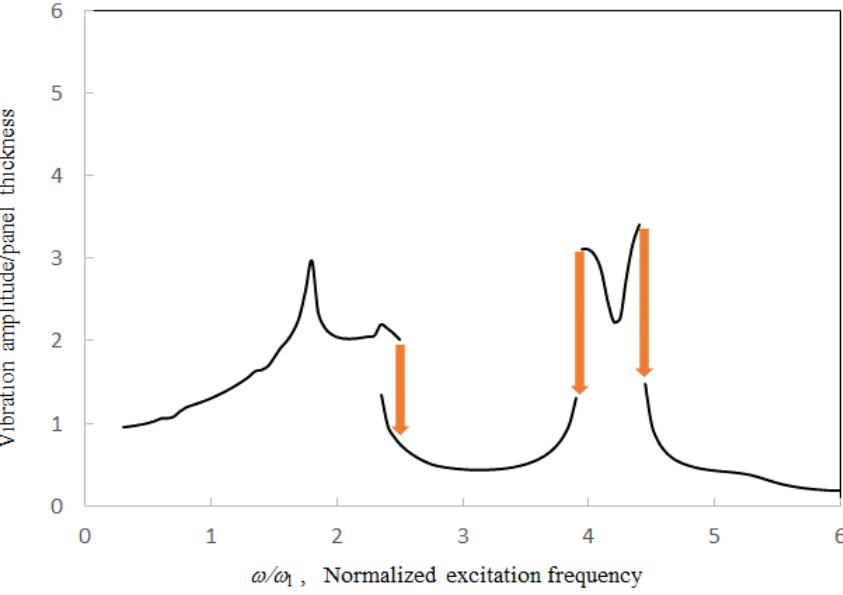
Figure 12. Vibration amplitude ratio versus normalized excitation frequency for various acoustic boundary conditions (number of structural modes = 2, number of acoustic modes = 4, γ = 2, θ = 5, l = 5 a ; the orange arrows represent the “jump phenomenon”).